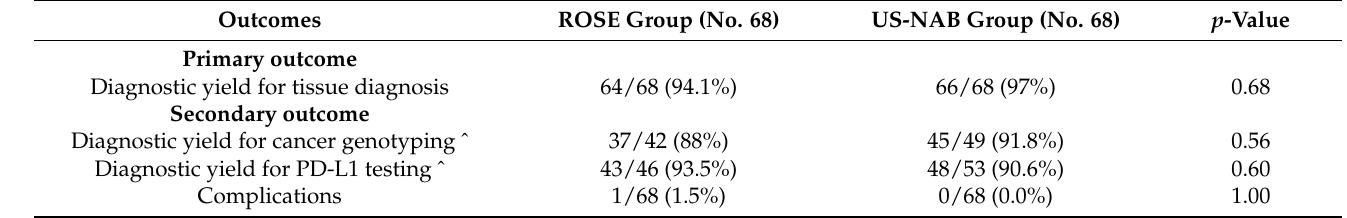
Table 2. Study outcomes.